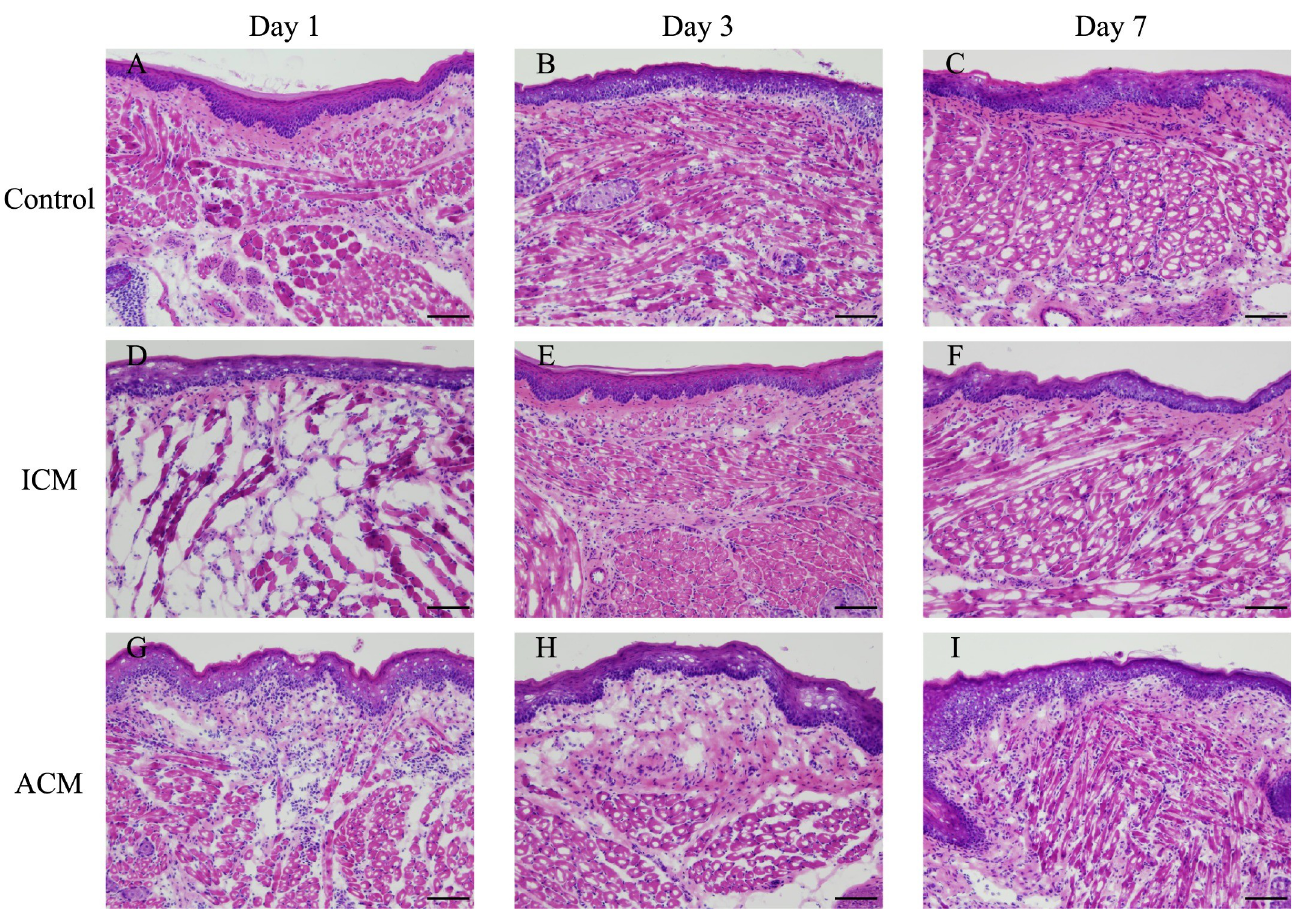
Fig 3. Histopathological analyses of HE staining in the oral mucosa of Ni-induced allergic mice. Oral mucosa tissue sections of each mouse were stained with HE at days 1, 3, and 7 after challenge. At day 1 after challenge, abundant infiltration of mononuclear cells, swelling of the oral mucosal epithelium and epidermal spongiosis were present in ACM mice (G). Scale bar = 10 μ